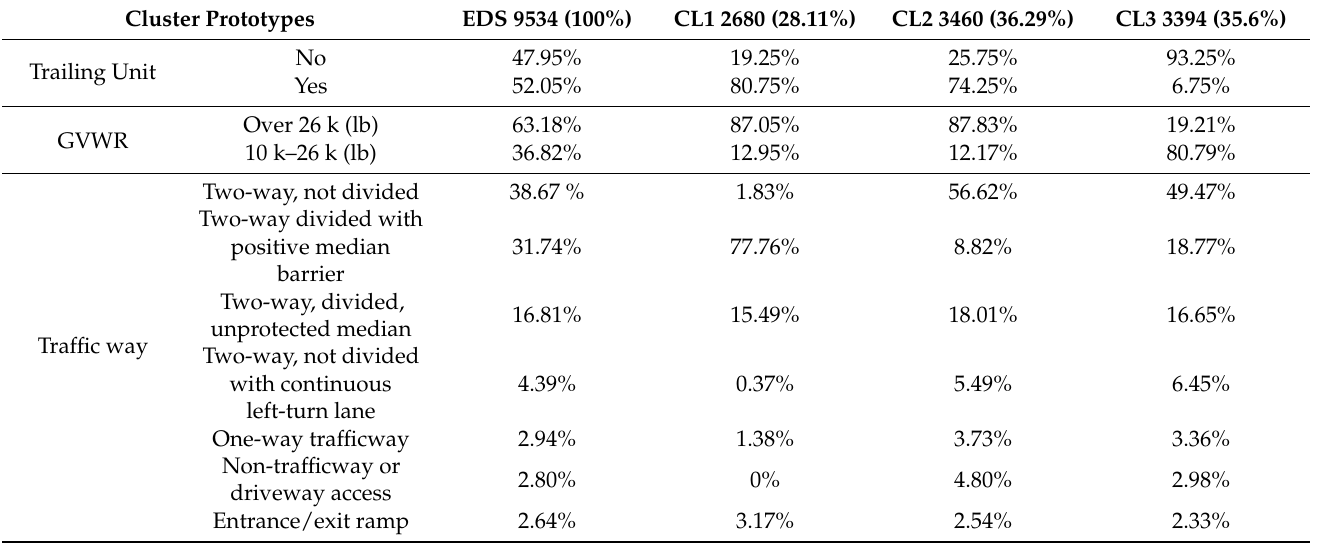
Table 5. Description of cluster